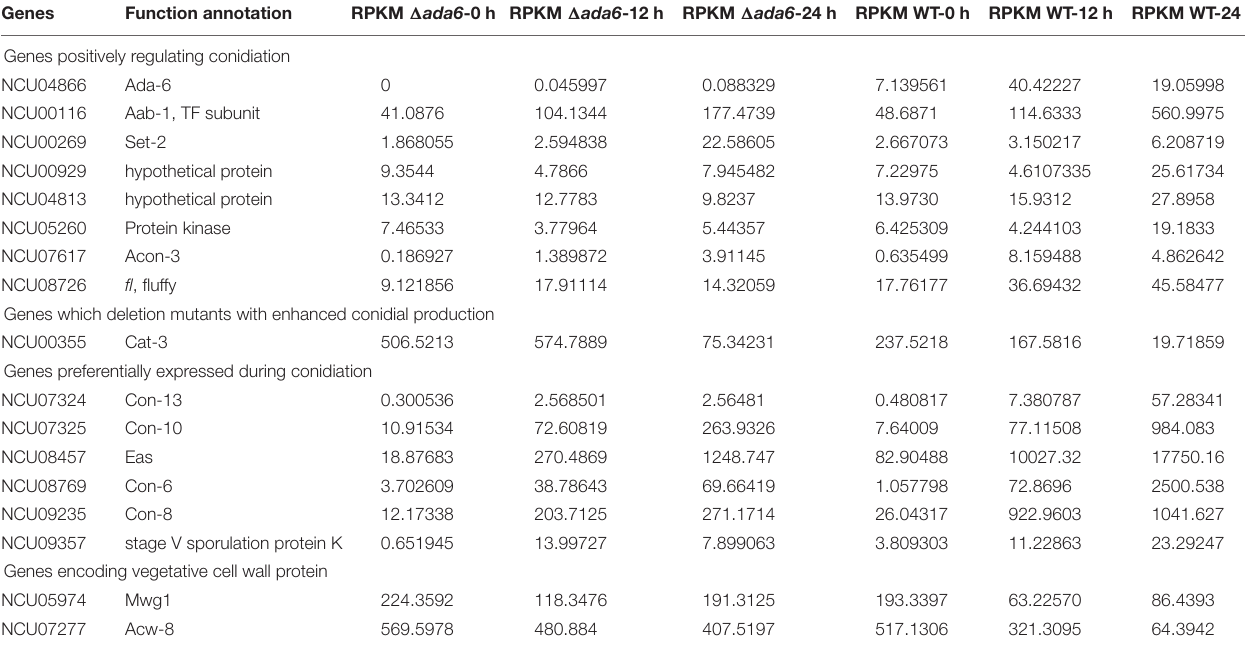
TABLE 3 | Transcriptional response to ada-6 deletion by the genes involved in conidiation and vegetative cell wall development. Genes Function